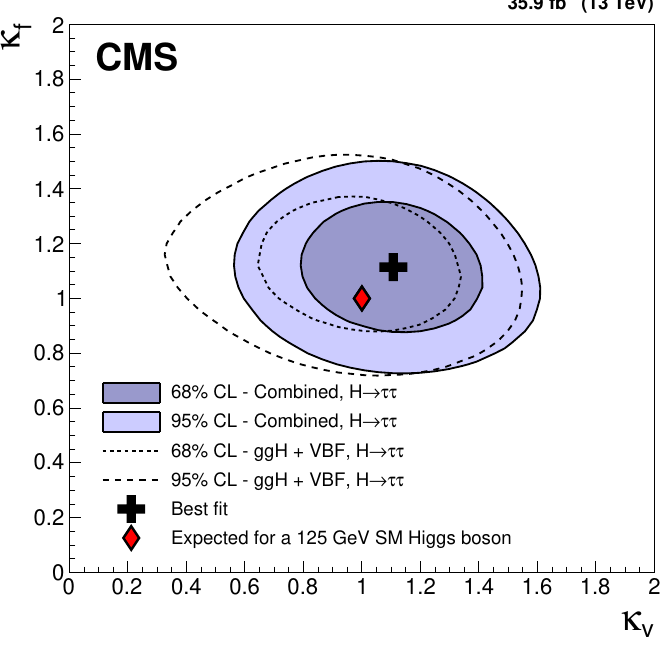
Figure 7 . Scans of the negative log-likelihood di(cid:11)erence as a function of (cid:20) V and (cid:20) f , for m H = 125 GeV. Contours corresponding to con(cid:12)dence levels (CL) of 68 and 95% are shown. All nuisance parameters are pro(cid:12)led for each point. The scan labeled as \Combined" is a combination of the WH and ZH targeted analysis detailed in this paper with the CMS analysis performed in the same data set for the same decay mode but targeting the gluon fusion and vector boson fusion production mechanisms [19]. The results for the gluon fusion and vector boson fusion analysis are represented by the dashed lines and are labeled as \ggH + VBF". For these scans, the included H ! WW and H ! ZZ processes are treated as